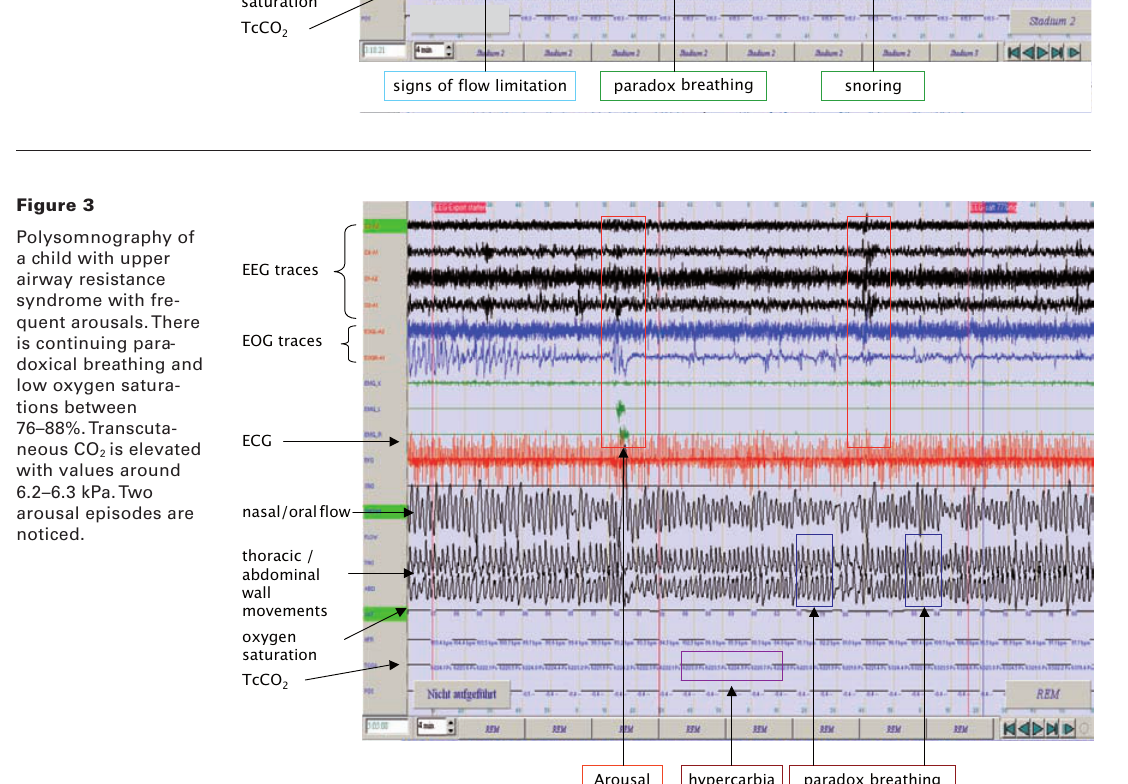
Polysomnography of a child with primary snoring. There is par- adoxical breathing as an indication of increased work of breathing due to upper airway ob- struction. In the nasal flow trace airflow limitation is recognis- able. Obvious snor- ing, synchronous to breathing. Note that there is no desatura- tion.